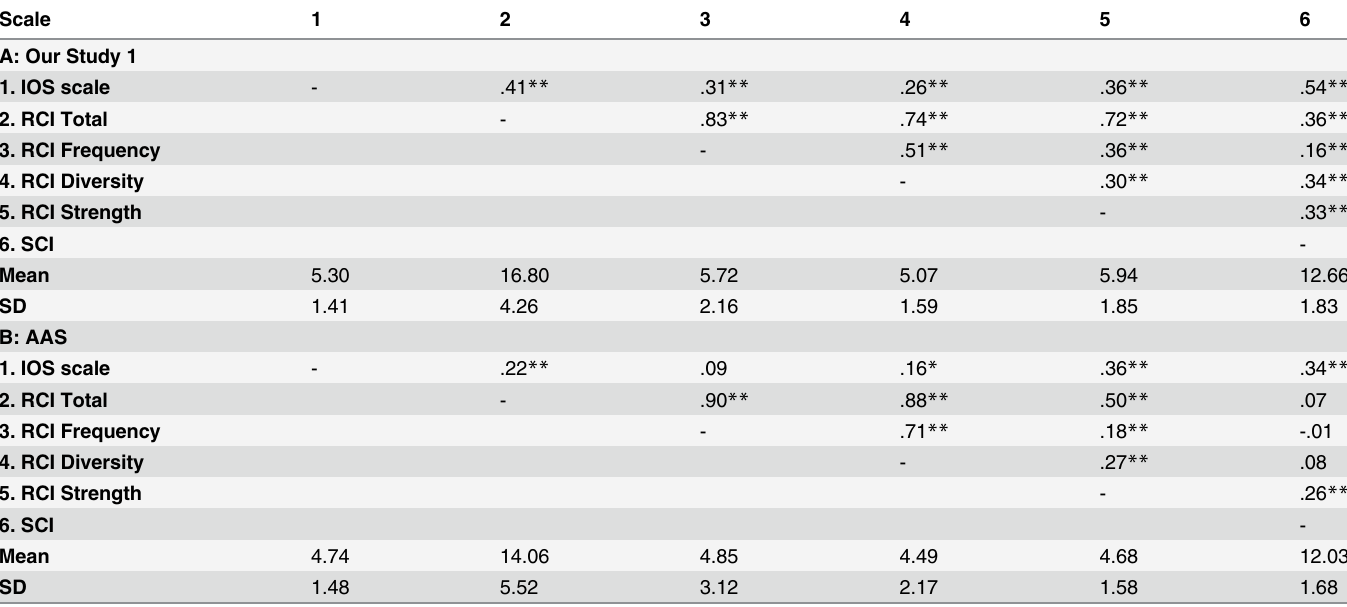
Table 1. Correlations among IOS Scale, RCI Scales, and SCI Scale.